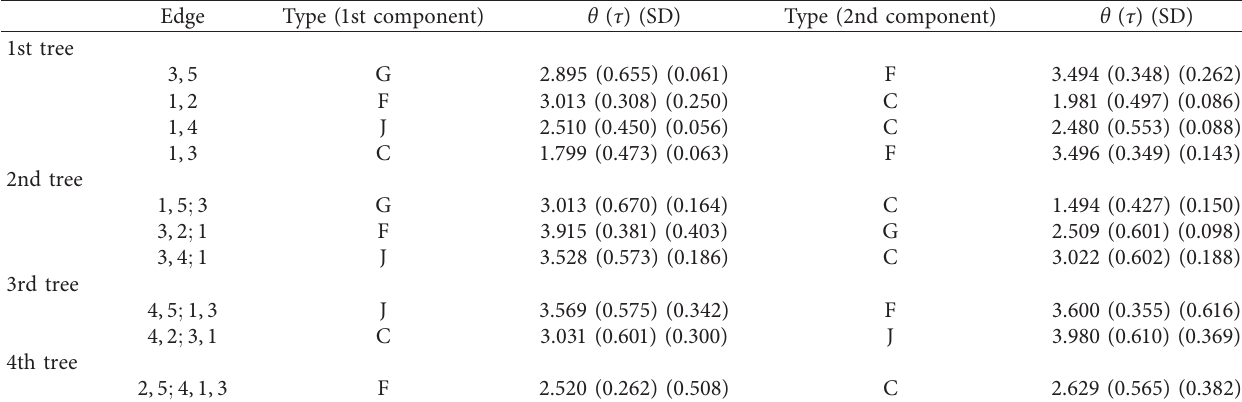
Table 2: Summary of the estimation results of the mixture of R-vine density model (simulation data of size 300), where SD stands for the standard deviation.